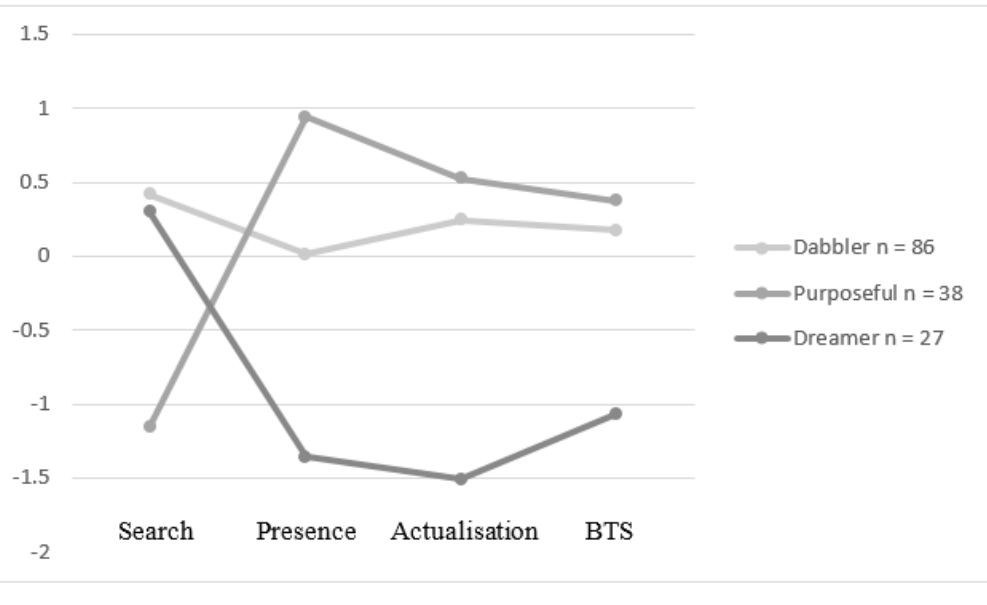
Figure 1. Finnish social services students’ purpose profiles based on